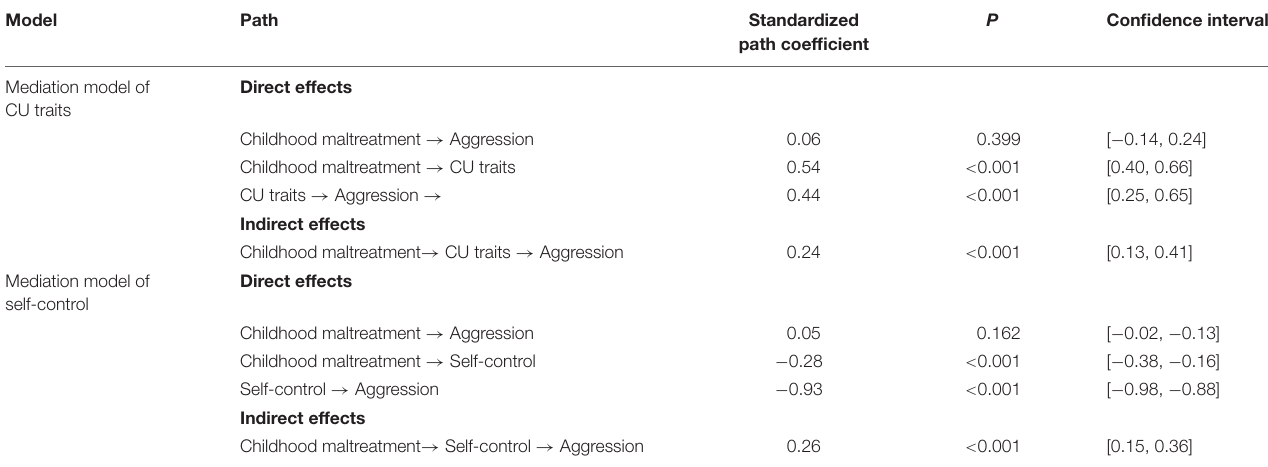
TABLE 6 | Direct and indirect effects in the mediation models with a single